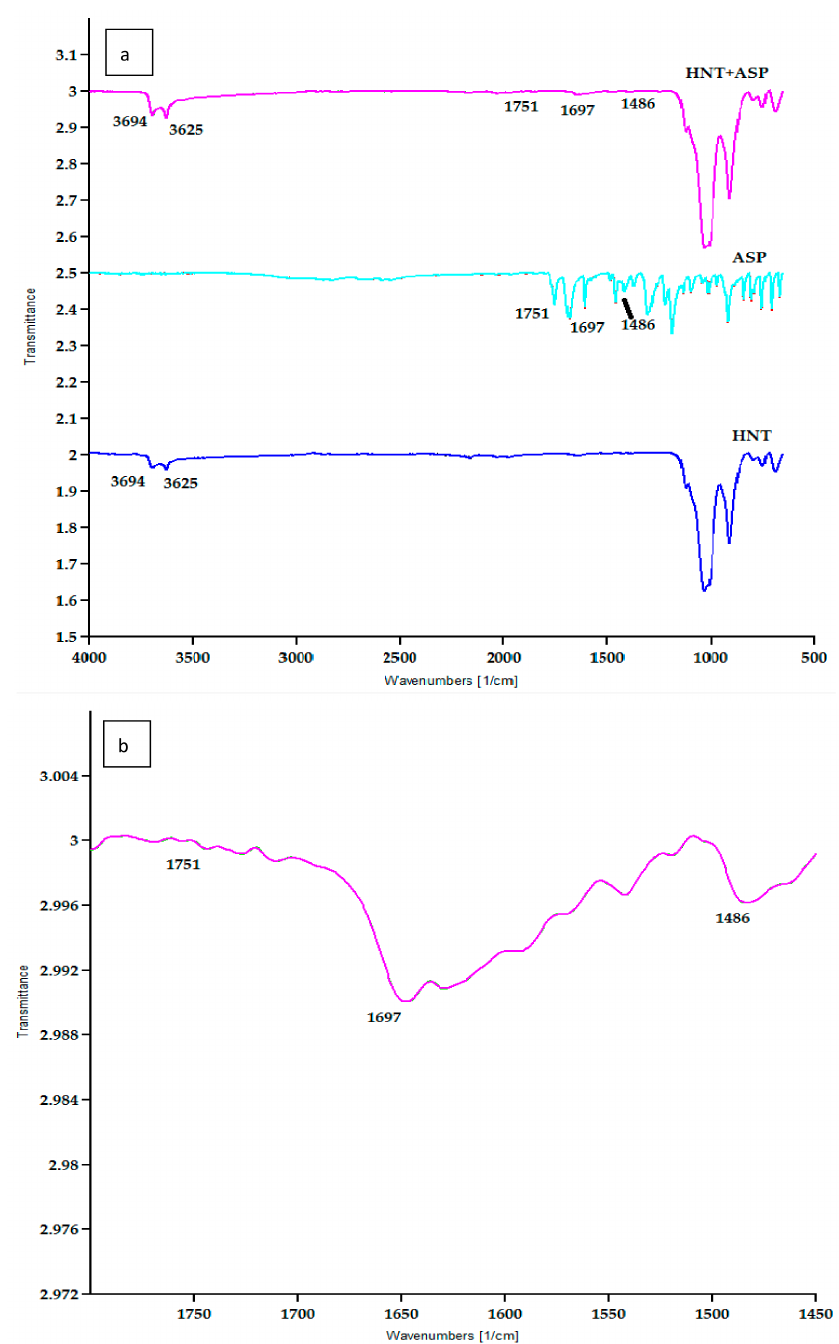
Figure 7. ( a ) FTIR spectra of HNT, ASP and ASP-loaded HNTs samples. The peaks of ASP at 1751 cm − 1 , 1697 cm − 1 and 1486 cm − 1 correspond with the peaks of ASP-loaded HNTs at 1751 cm − 1 , 1697 cm − 1 and 1486 cm − 1 . This indicates the drug is loaded in the HNT. ( b ) Higher magnification of HNT + ASP